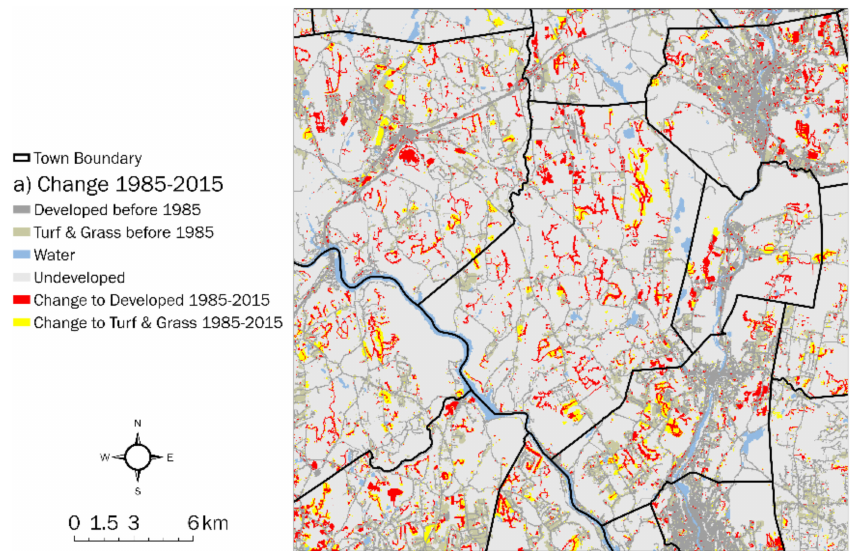
Figure 21. A several town area showing areas changed to the developed (red) and turf and grass (yellow) categories during the study period often reveals attenuated patterns that suggest “sprawl” style suburban